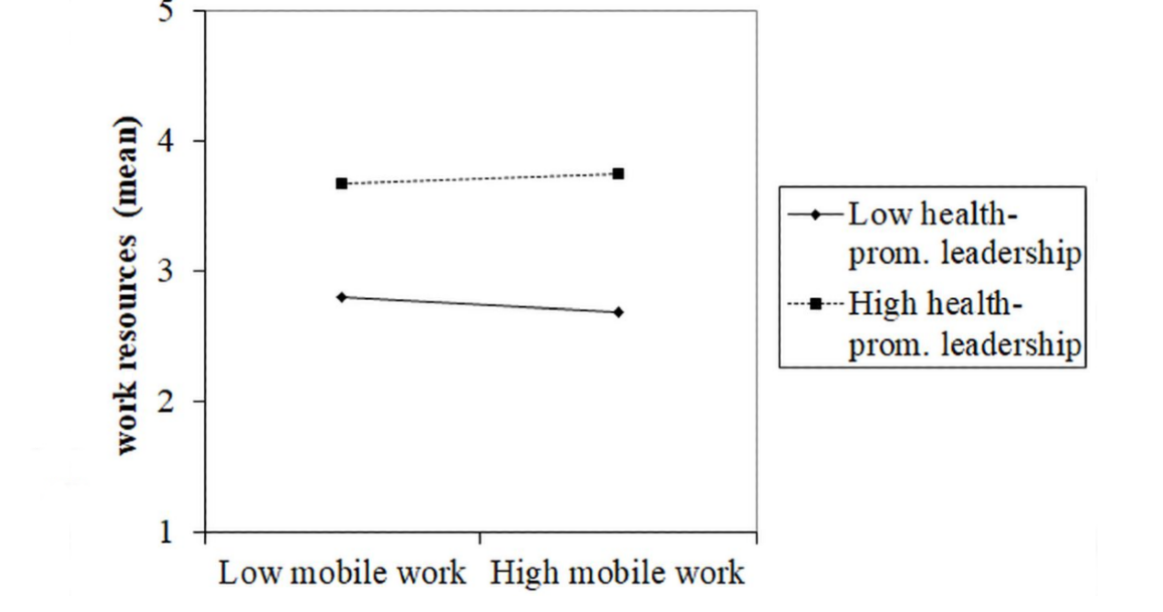
Figure 4. Effect of a two-way interaction between mobile work and health-promoting leadership on work-related resources. prom.: